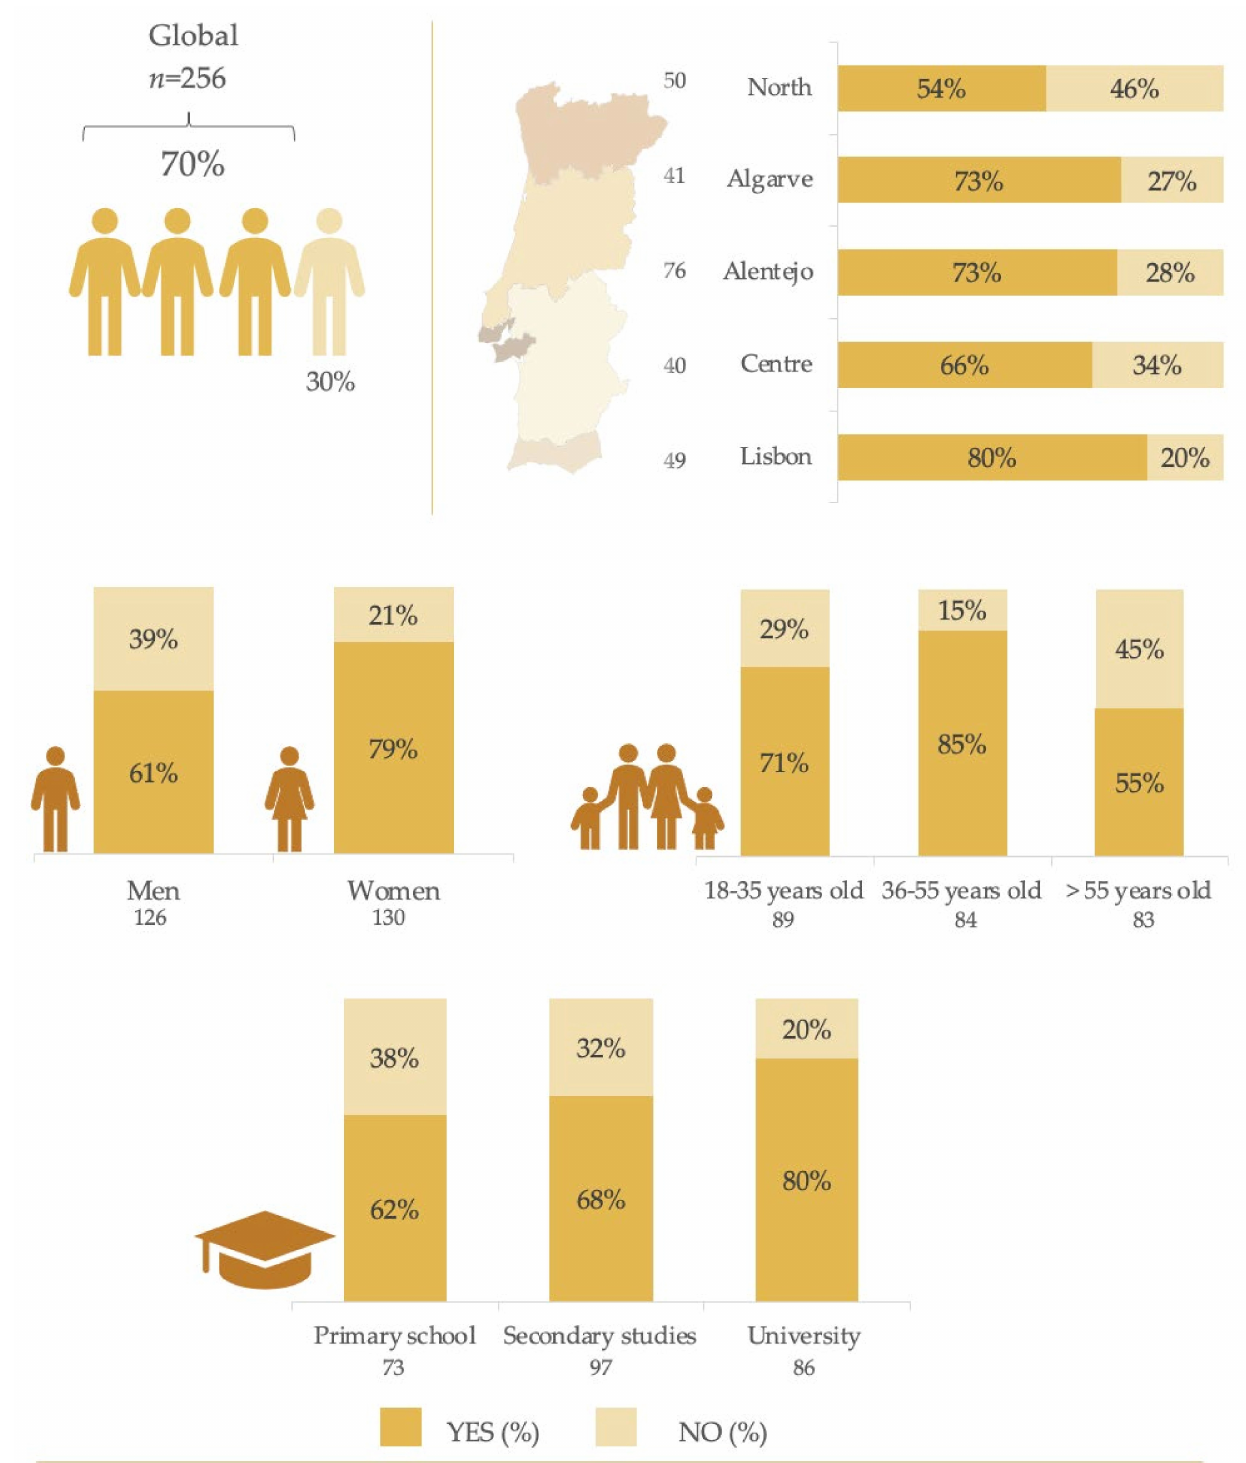
Figure 1. Consumption of low- and no-calorie sweeteners (LNCS) by the Portuguese population. It should be noted that the presence of sweeteners is not homogeneous throughout all foodstuffs that make up each food group. We consider that, in the context of dietary pat- terns, it is relevant to highlight both the presence and absence of LNCS, and consequently Table S1 lists all the food and beverage products that make up each group and the presence or absence of LNCS for each